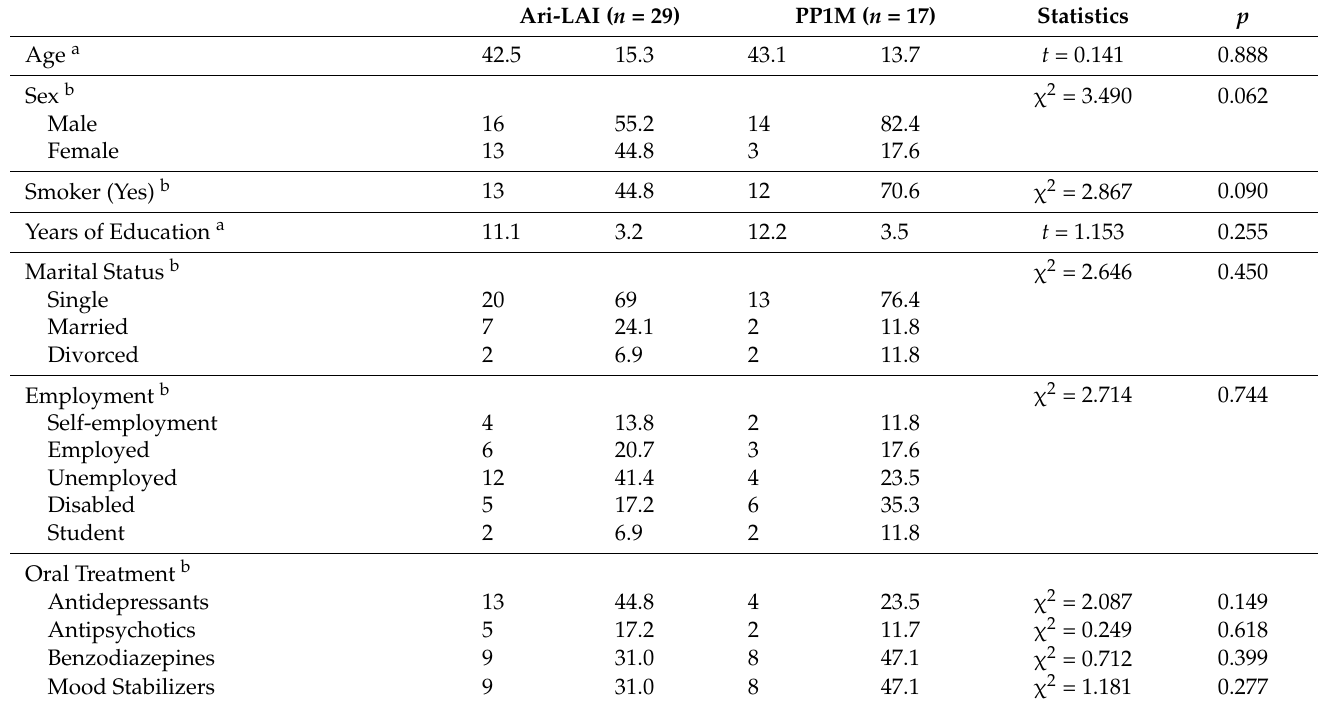
Table 1. Baseline demographics and assessment of the sample.